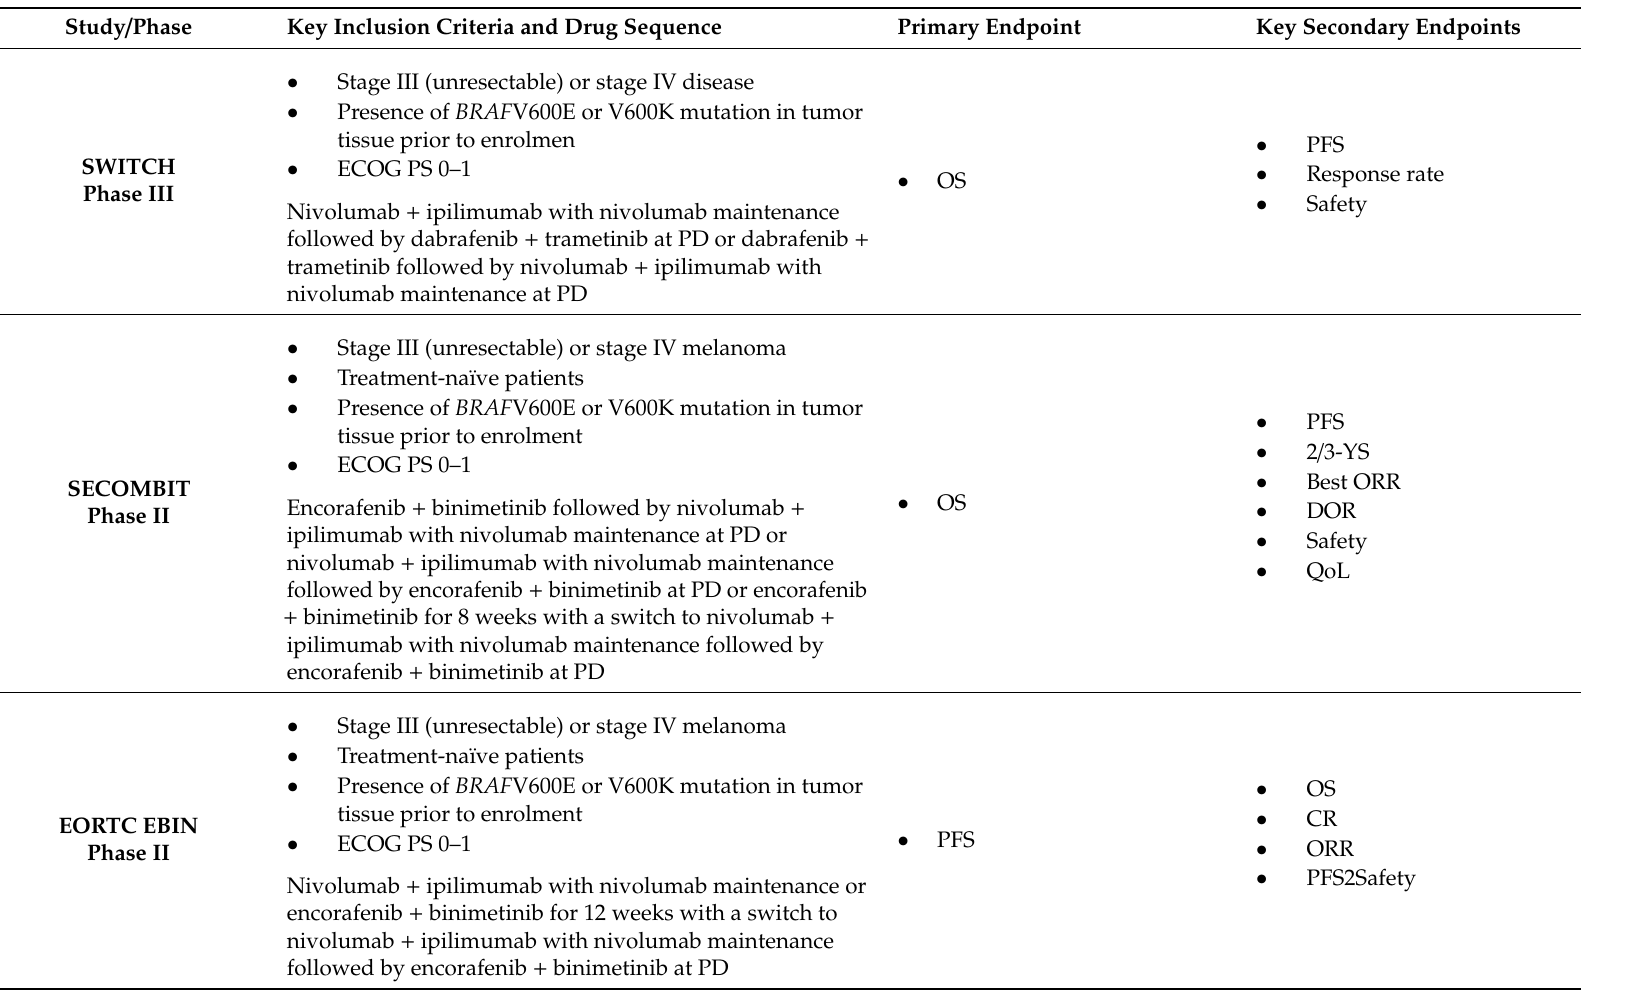
Table 2. The summary of the most important current clinical trials with targeted therapy and immune checkpoint inhibitors in sequential